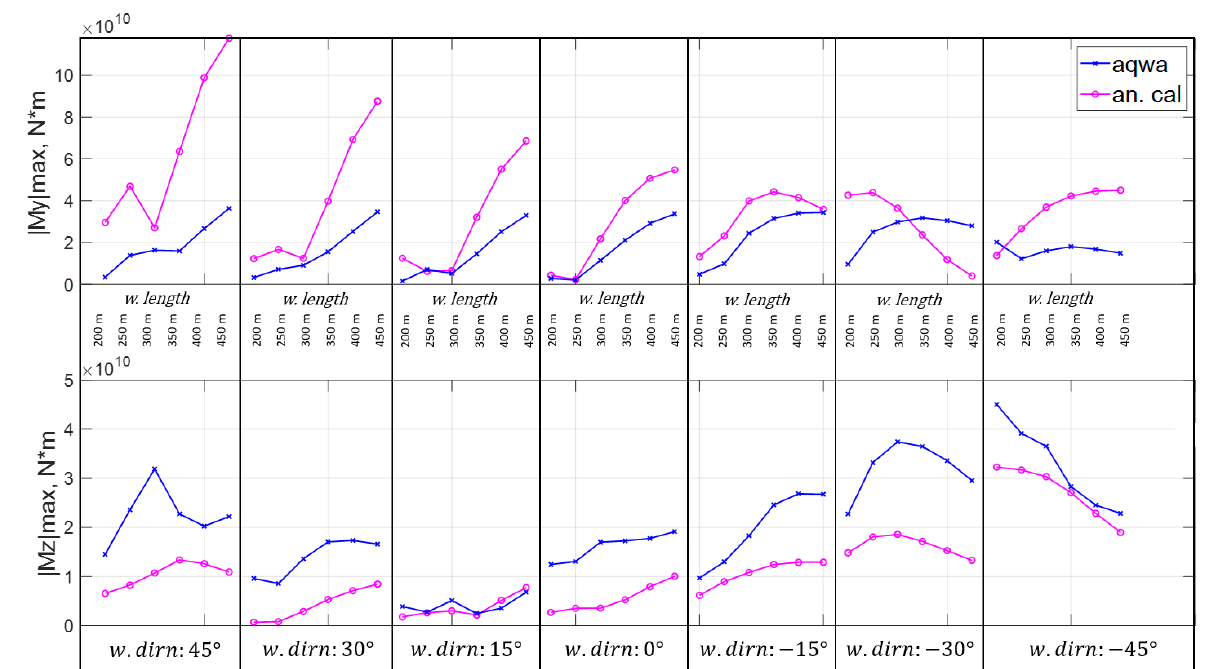
Figure 8. A comparison of the maximal bending moments M y (upper sub figure) and M z (lower sub figure). The wave splitting forces calculation by AQWA (complete hydrodynamic solution) is in blue. The hydrostatic wave load by analytic calculation is in magenta. Each subplot presents a wave direction. For each direction, the wavelength increased from 200 to 450